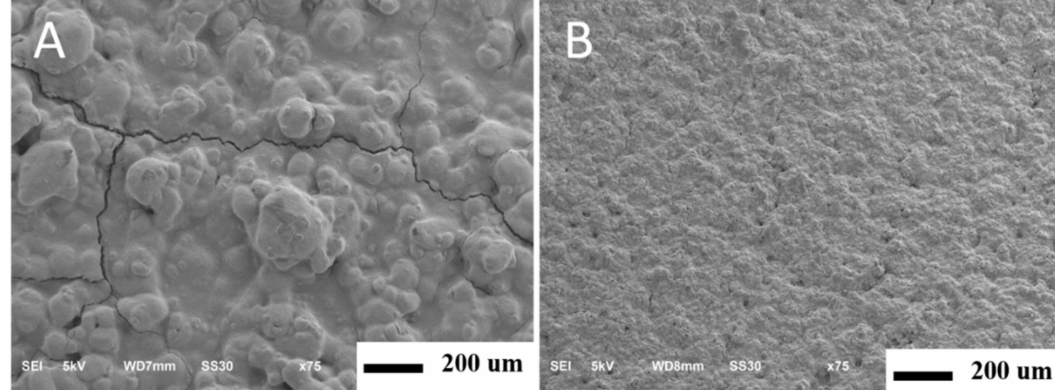
Figure 5. SEM images of anode made of silicon flakes with ( A ) nanocarbon coatings and ( B ) nanocarbon coats, followed by ball milling.